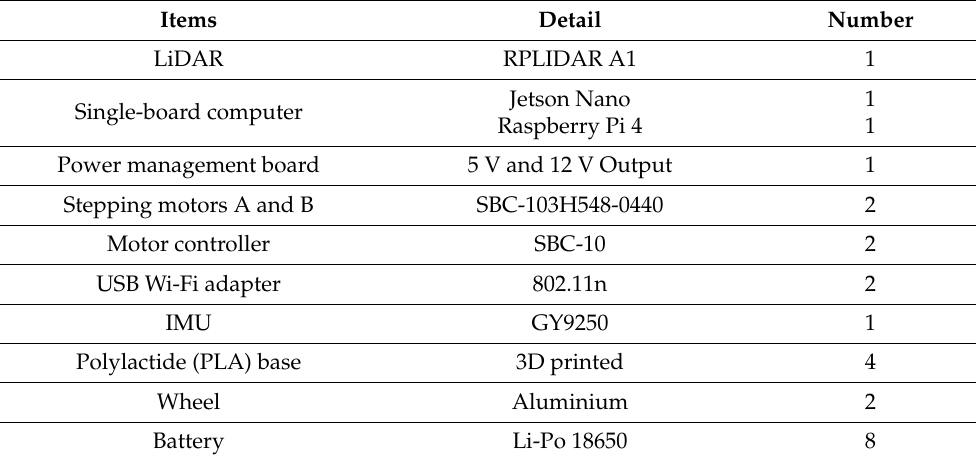
Table 2. Owlbot components.